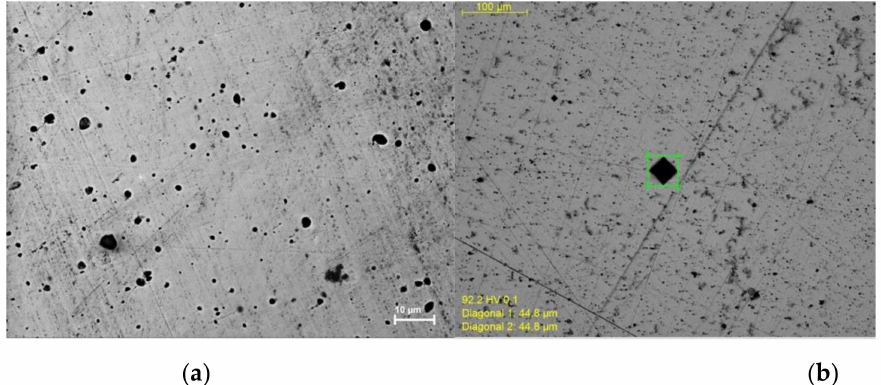
Figure 8. SEM image of polished HIP sample. ( a ) A 50 / 50 Ni / NiO sample after HIP treatment appears inhomogeneous. There are no longer necks and particles, but rather continuous Ni metal zones and voids. ( b ) Image taken with micro hardness tester showing diamond shaped (~45 µ m) hardness